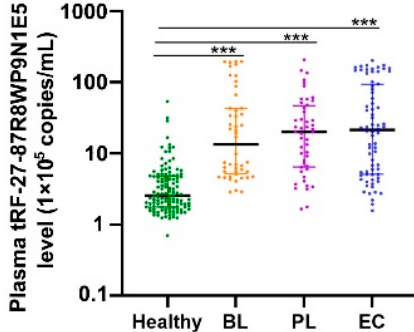
Figure 4. Plasma tRF-27 levels in healthy individuals, patients with benign gastric lesions, and patients with malignant gastric lesions. Data are presented as medians (interquartile ranges from 25% to 75%): healthy individuals ( n = 120); BL, patients with benign lesions ( n = 48); PL, patients with precancerous lesions ( n = 48); and EC, patients with early cancer ( n = 72). The colors indicate different groups. *** p < 0.001.